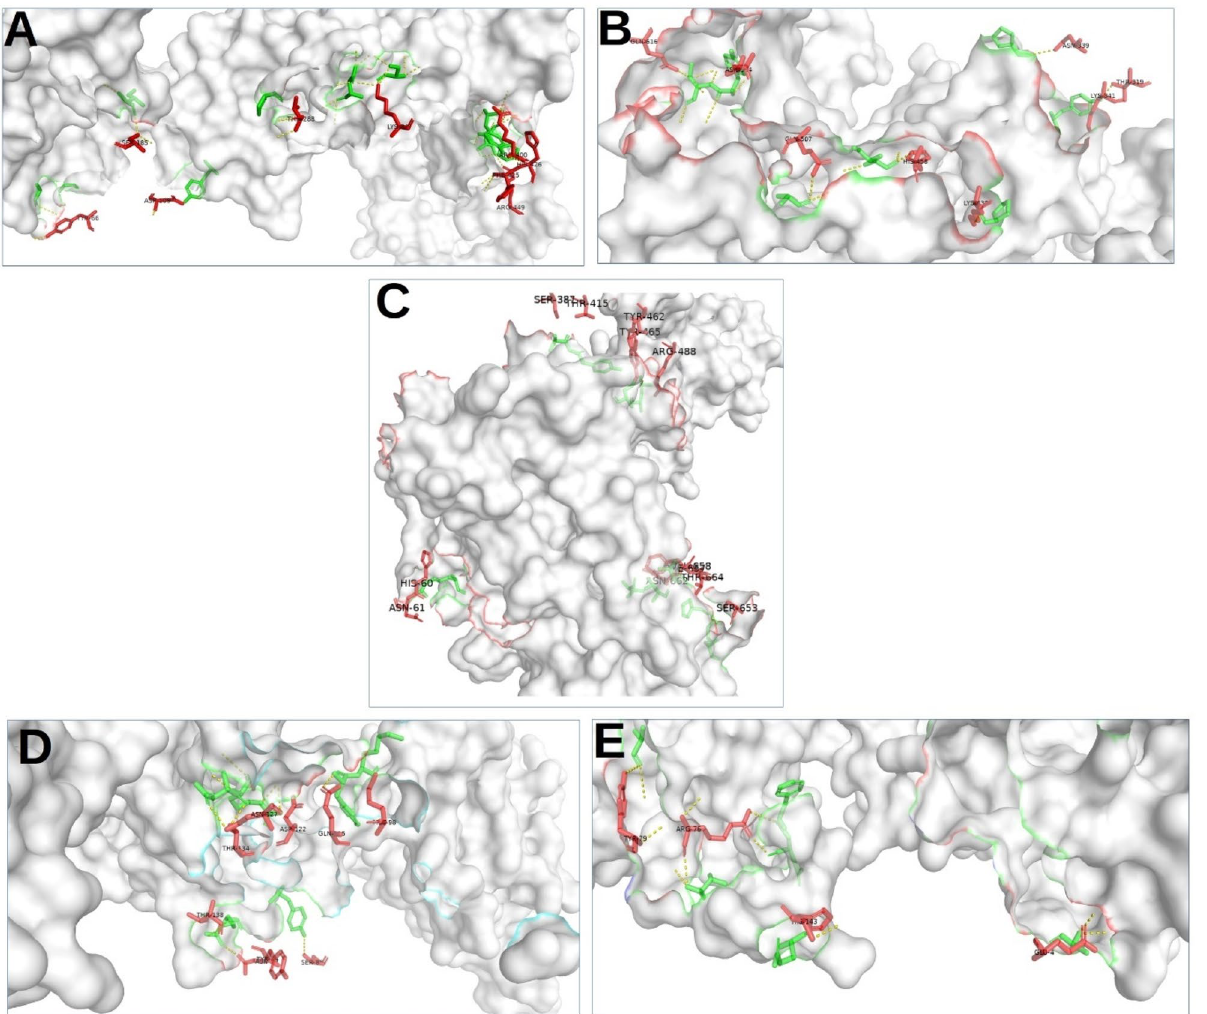
Figure 5. Hydrogen bond interaction map with the pymol of the CCHFV chimeric vaccine in green while the red colour ( A ) TLR-2, ( B ) TLR-3, ( C ) TRR-4MHC-II, ( D ) MHC-I, and ( E ) MHC-II.